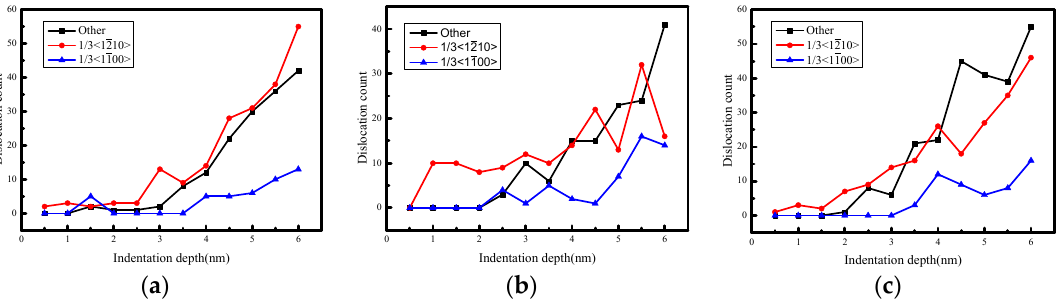
Figure 10. Broken line diagram of dislocation number on different crystal planes with different indentation depths. ( a ) (0001) crystal plane ( b ) (1100) crystal plane ( c ) (2110) crystal